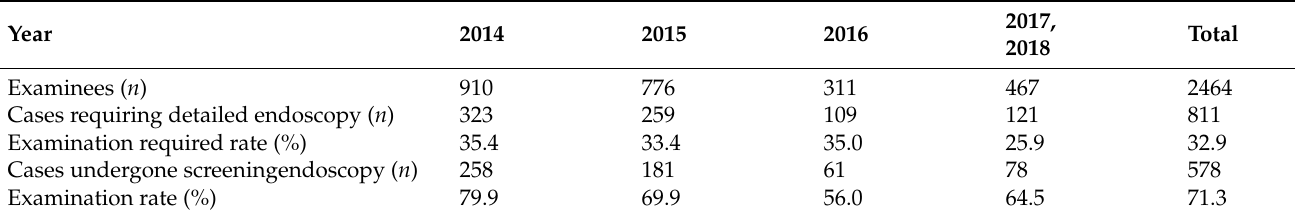
Table 1. Results of H. pylori antibody test project in Hoki-cho, Tottori Prefecture.